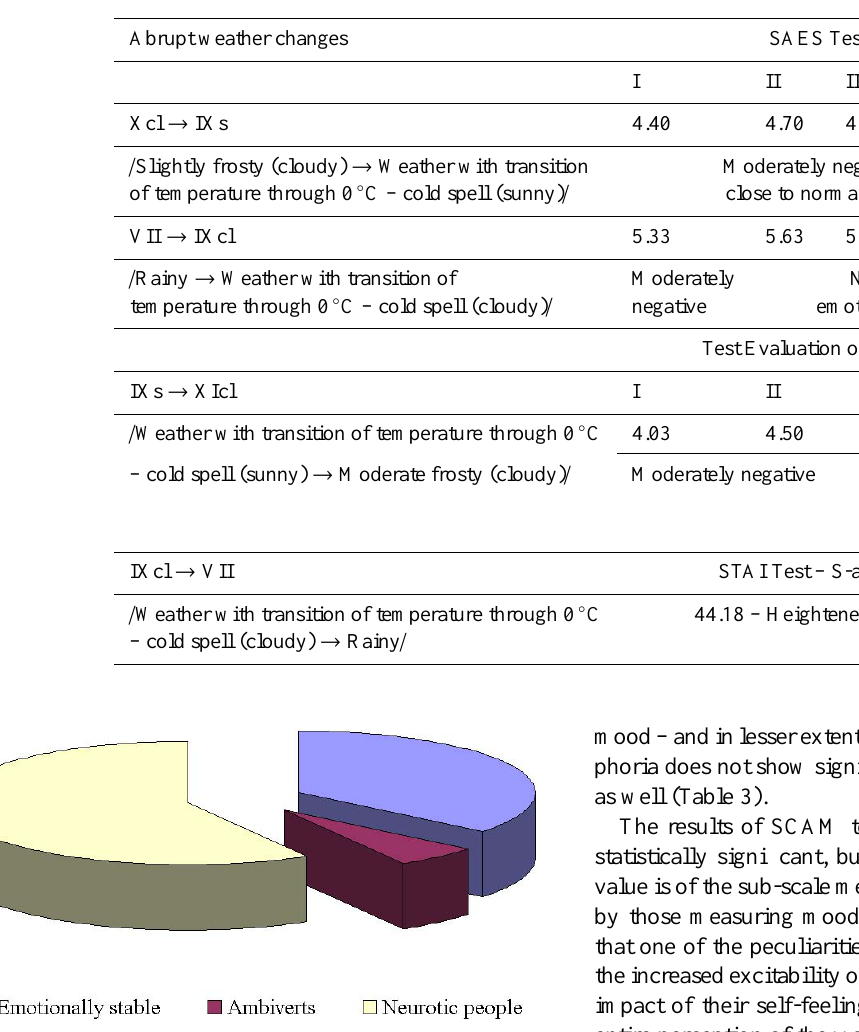
Figure 4. Distribution of the investigated people according to di- mention Neuroticism /